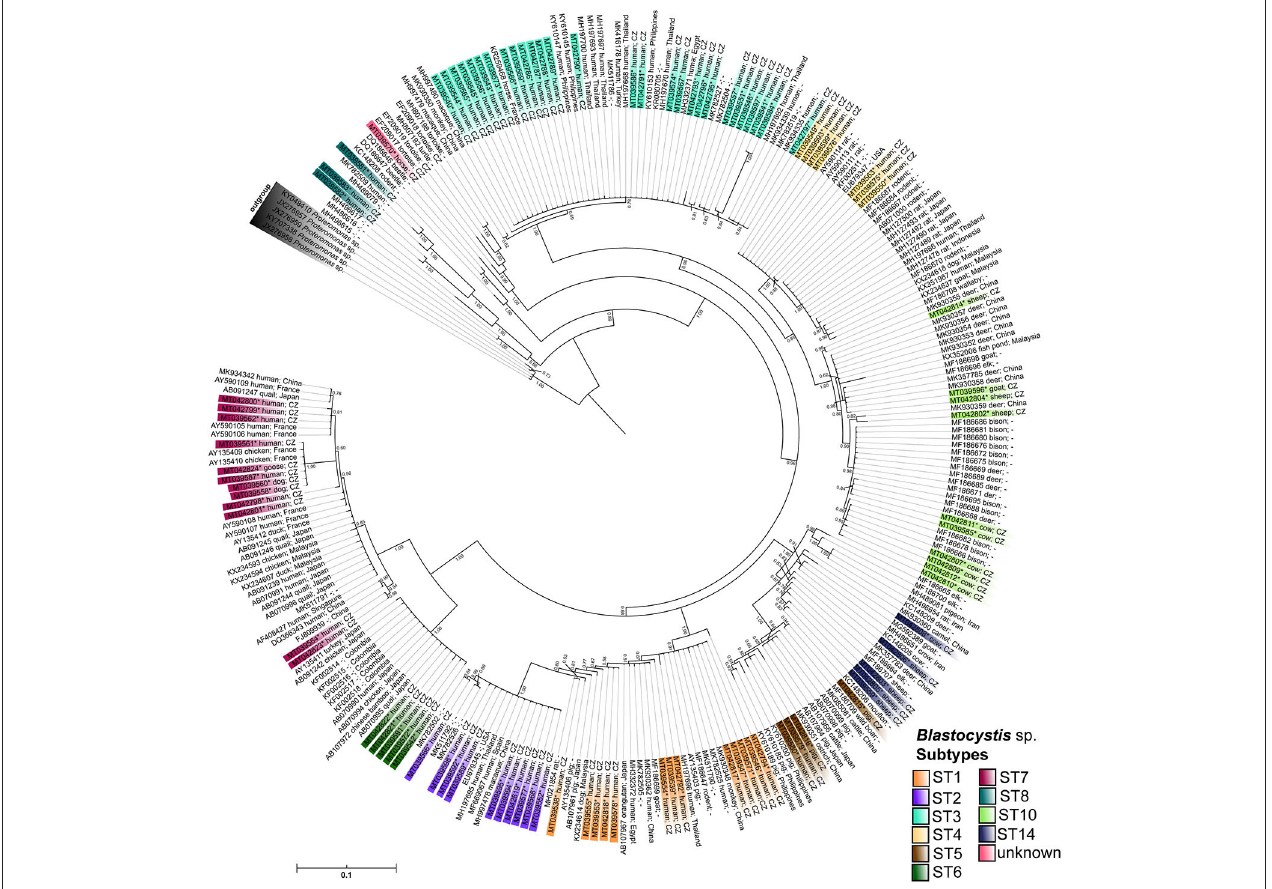
FIGURE 2 | The MrBayes tree based on Blastocystis SSU rDNA sequences. The posterior probabilities are shown as a branch supports; sequences of Proteromonas sp. were used as an outgroup to root the final tree. Sequences obtained in a frame of this study are marked by the asterisk and highlighted by the color gradient corresponding to the assigned Blastocystis subtypes. All sequences are labeled by NCBI accession numbers, the host, and locality if